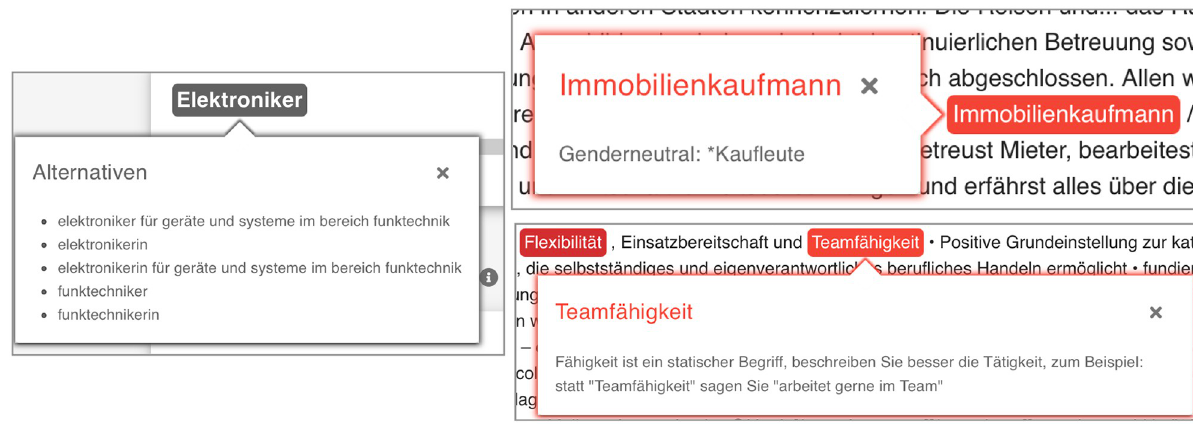
Fig 3. Examples of words highlighted in BetterAds. Left: word alternatives for the job title ‘Elektroniker’ (‘electronics technician’) in the masculine base form include suggestions for more detailed specification of the job title as well as the feminine base form ‘Elektronikerin’. Use of word embeddings can be seen, for example, in semantically similar suggestions such as ‘Funktechniker’ (‘radio technician’). Top right: The word ‘Immobilienkaufmann’ (‘real estate agent’) contains the suffix ‘Kaufmann’ (‘merchant’, masculine base form containing the word ‘Mann’, meaning ‘man’), which is suggested to be replaced by the gender-neutral phrase ‘Kaufleute’. Bottom right: Utilizing LCM theory, the tool suggests replacing the static term ‘Teamfa¨higkeit’ (‘team capability’) with a description of the activity such as ‘likes to work in a team’.